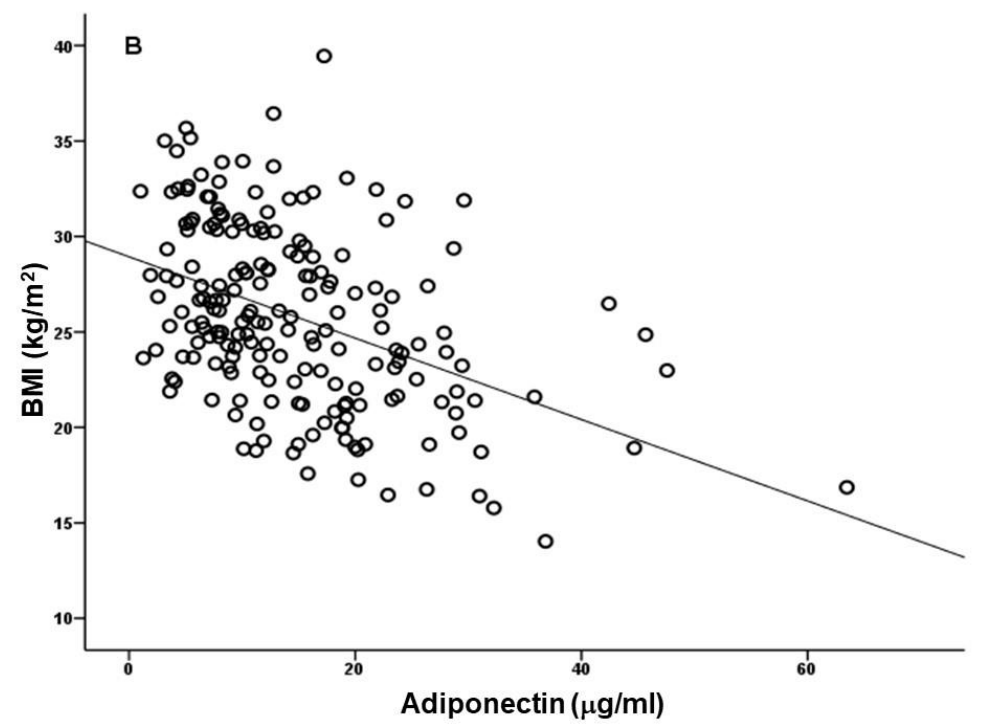
Figure 1. Association of circulating levels of adiponectin with body mass index (BMI) values in end-stage renal disease patients under hemodialysis ( r = − 0.431, p < 0.001). Adapted from Coimbra et al. 2019 [9].